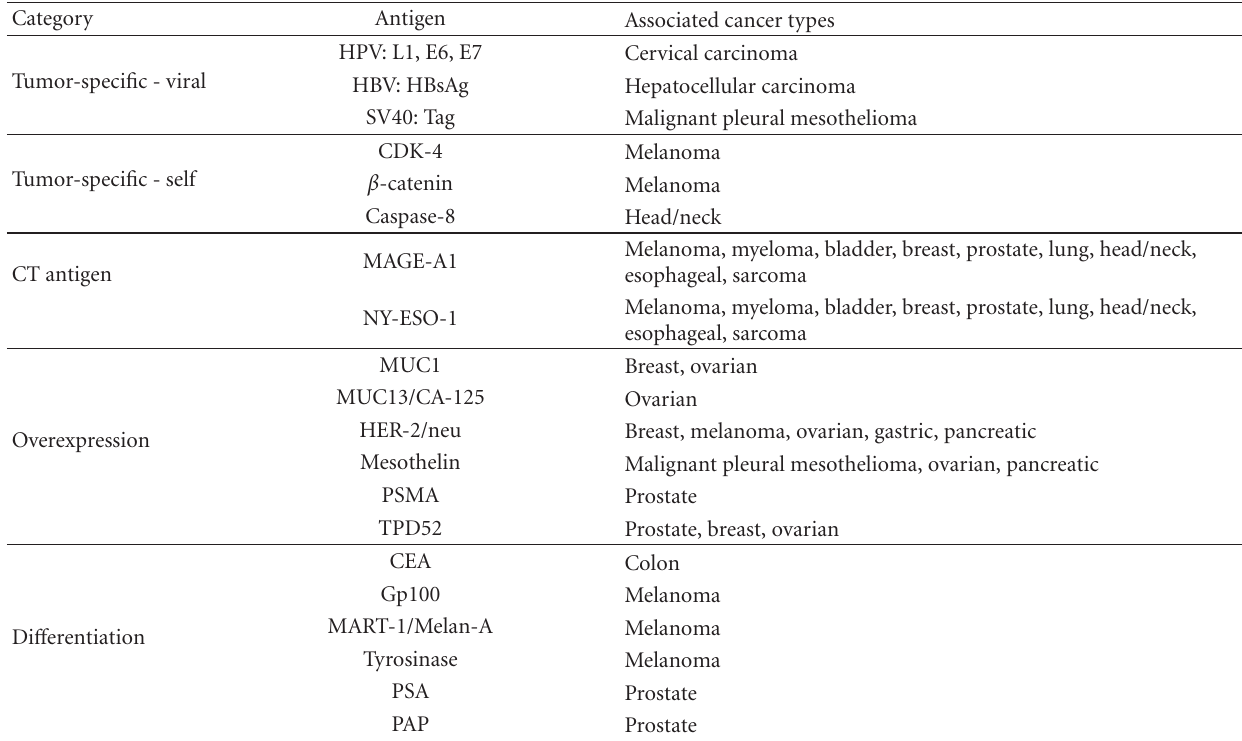
Table 1: Examples of common tumor